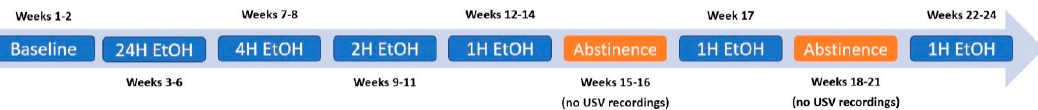
Figure 1. Schematic of experimental timeline. Ultrasonic vocalizations (USV)s were recorded from adult, male Long–Evans rats with variable access to 3-bottle choice ethanol (EtOH) (water, 15% EtOH, 30% EtOH) or water controls over a 24-week period.